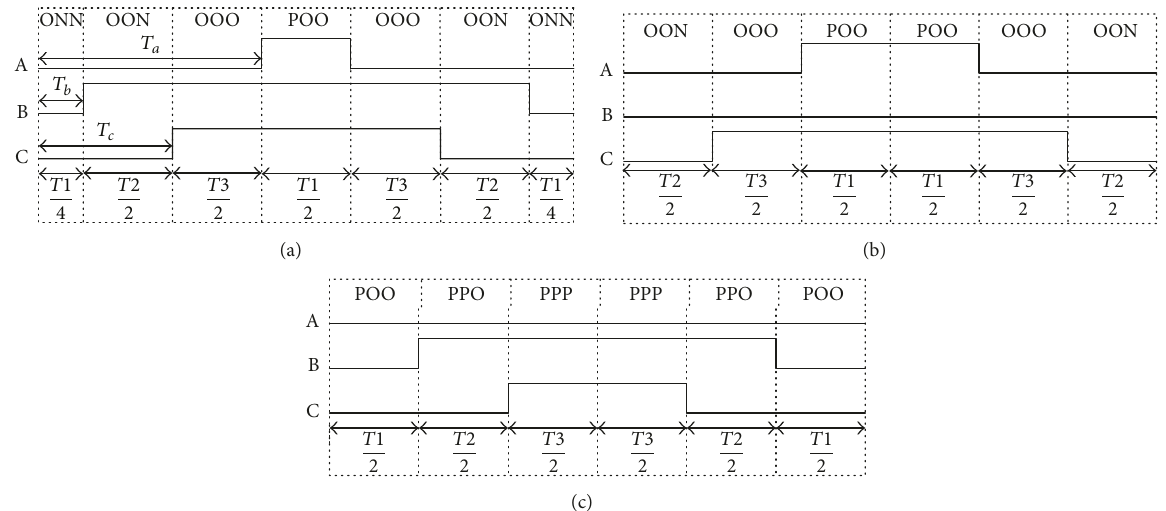
Figure 7: The sequence of voltage vectors and its action times in region I-1. (a) Conventional switching sequence. (b) After 𝑇 low is subtracted. (c) After the switching sequence is rearranged.